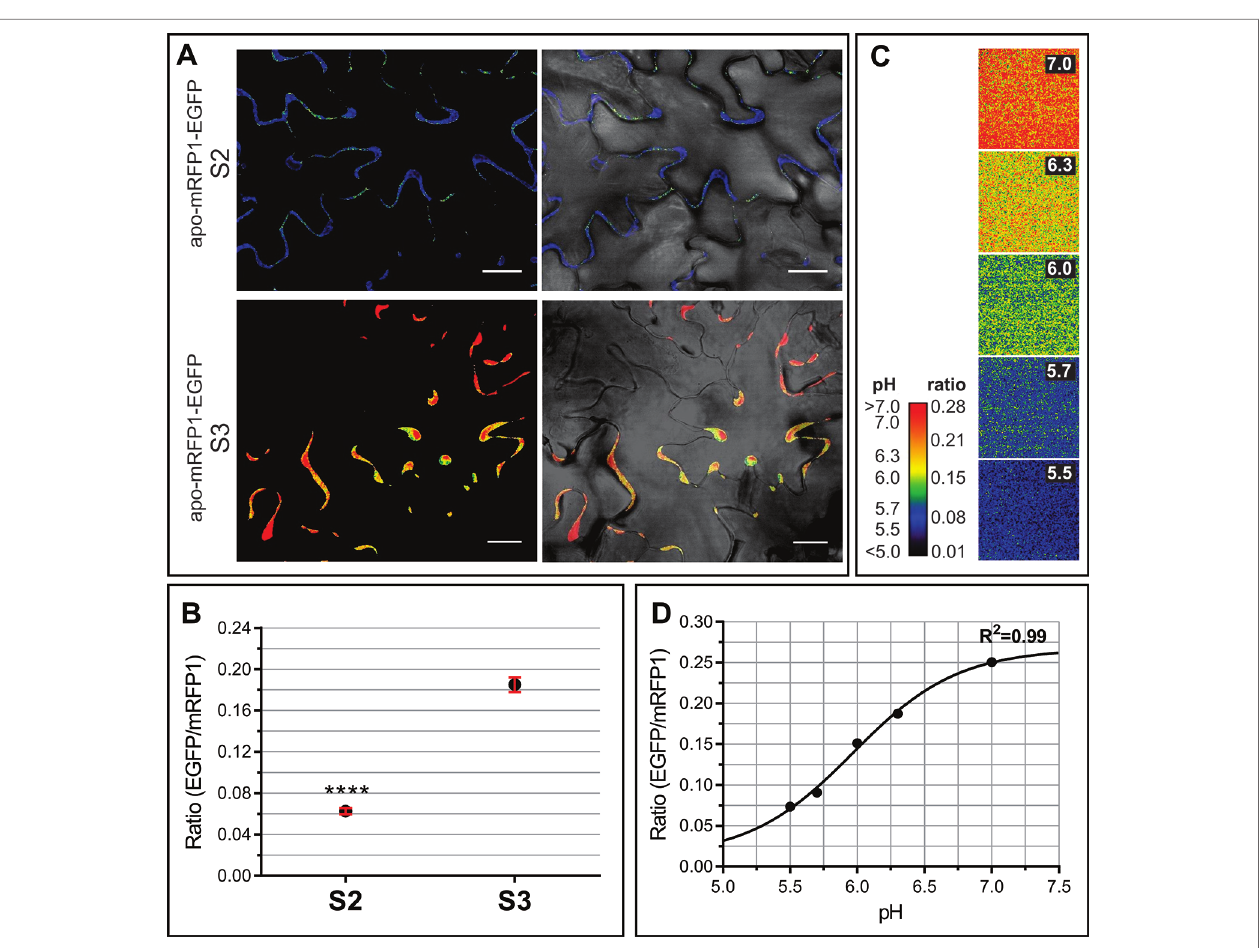
FIGURE 4 | Apoplastic pH of S2 and S3 leaves. In vivo analysis of apoplastic pH using the Arabidopsis transgenic line apo-mRFP1-EGFP (Gjetting et al., 2012). The pH was estimated according to the fl uorescence intensity ratio EGFP/mRFP for each region of interest (ROI). (A) Left panels show representative ratio images of the leaf epidermis in S2 and S3 leaves, right panels show the merge of ratio images with their corresponding light fi eld. (B) EGFP/mRFP ratio of leaf S2 and S3 epidermal cells. The values shown correspond to the mean ± SEM of 39 and 119 ROIs from S2 and S3 leaves, respectively, taken from at least three different leaves for each stage. A Student t test ( P ≤ 0.05) was performed, asterisks indicate signi fi cant differences: ****, P < 0.0001. (C , D) . Ex vivo calibration of the apo-pHusion sensor. (C) Ratio images of AWF incubated at different pH units, used to construct the calibration curve. For visual image presentation of ratio images, a pseudocolor look-up table was designed. (D) Calibration curve. PH was estimated according to the intensities of GFP and RFP fl uorescence. Confocal data acquisition was performed on a Leica TCS SP5 II confocal laser scanning microscope. Image data were analyzed using the ImageJ software. Scale bar = 20 m